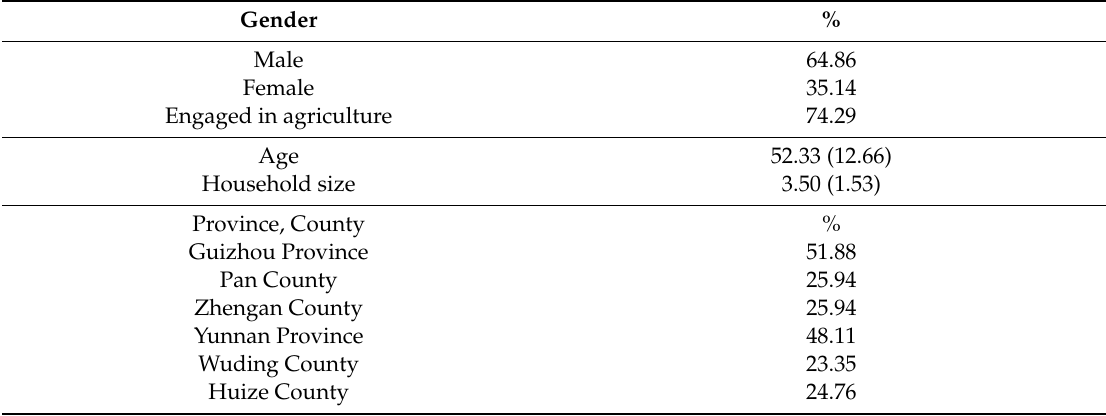
Table 1. Characteristics of the study sample ( n =